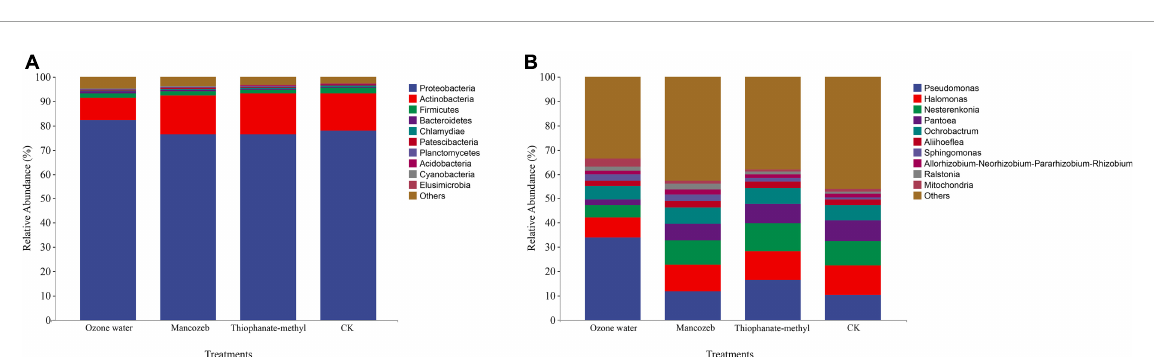
significantly differed among the groups: from large to small, ozonated water treatment group (72.68%), thiophanate-methyl treatment group (63.52%), mancozeb treatment group (39.73%), and CK group (29.72%). The relative abundance of Aspergillus in the CK group (5.02%) was significantly higher than